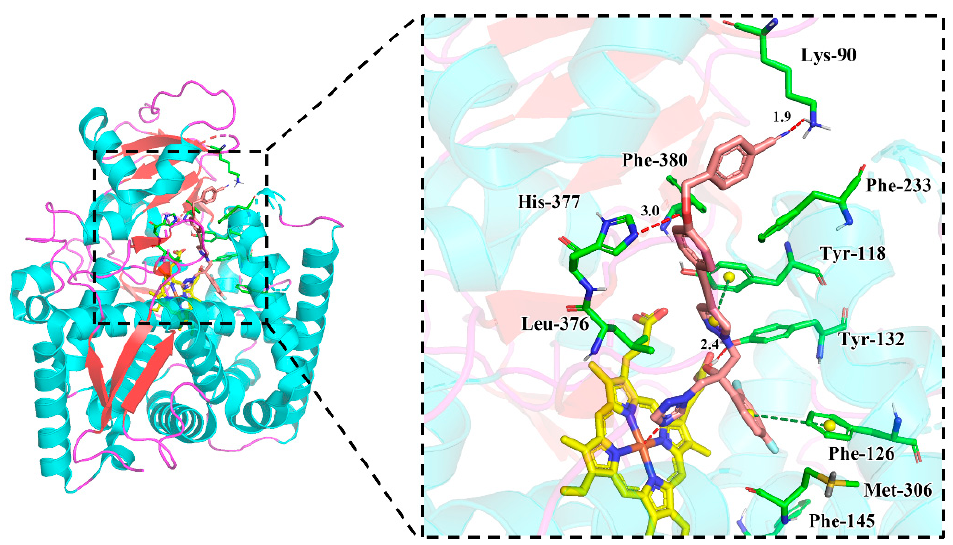
Figure 7. The binding mode of compound 6c in the active site of CYP51. Compound 6c , heme group, residues are shown in brown, yellow or green sticks, respectively. Hydrogen-bonding interaction was shown in red and π – π stacking interaction was shown in forest green. Image depicting the proposed binding mode was generated using PyMOL.